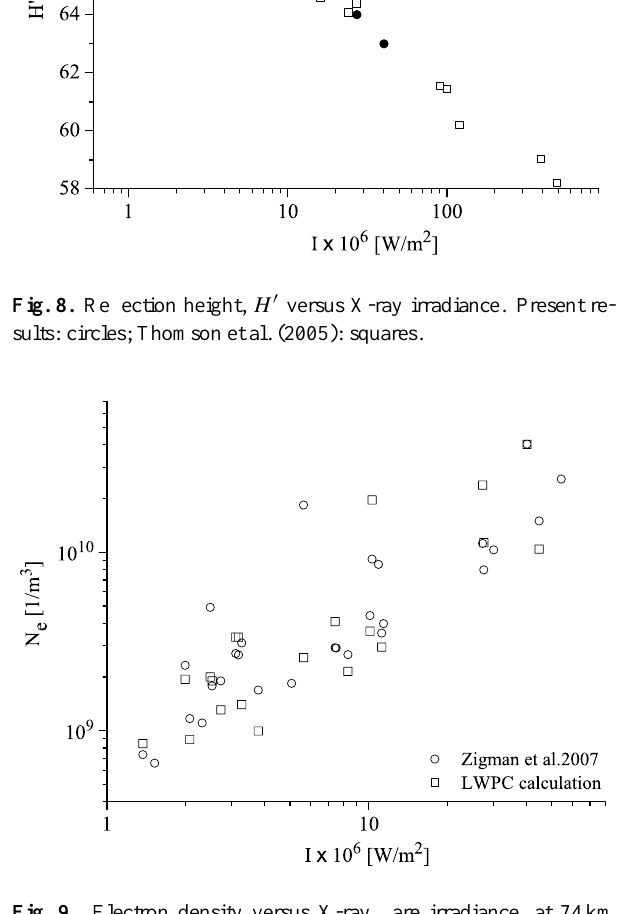
Fig. 9. Electron density versus X-ray flare irradiance, at 74km height: present results squares – from β and H 0 parameters esti- mated for the flare events on 12 July 2005 and 13 July 2004; circles – N e (t) method (ˇZigman et al., 2007) applied to the same series of